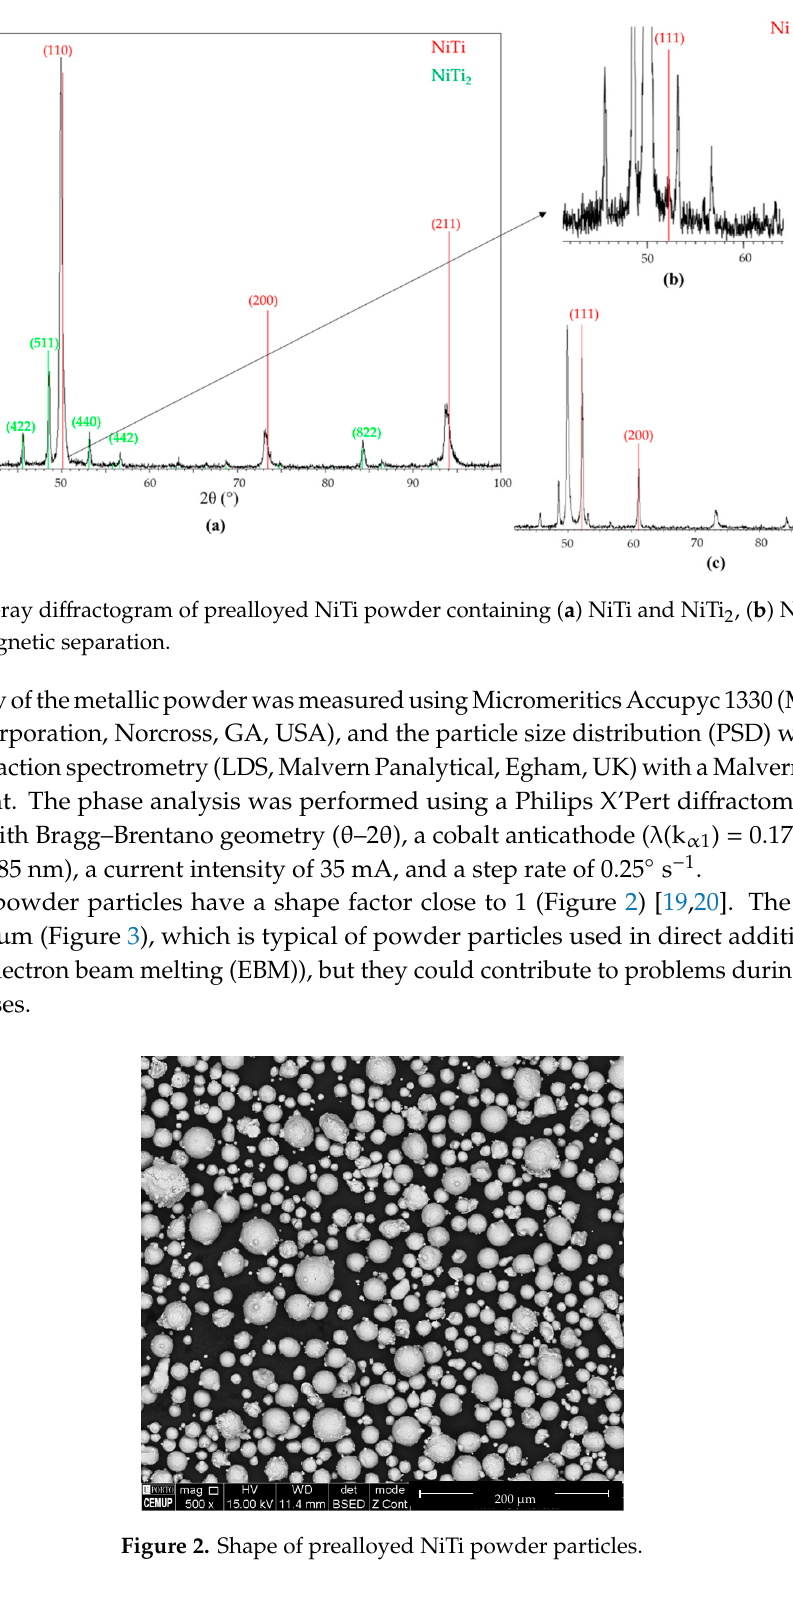
Figure 2. Shape of prealloyed NiTi powder particles.